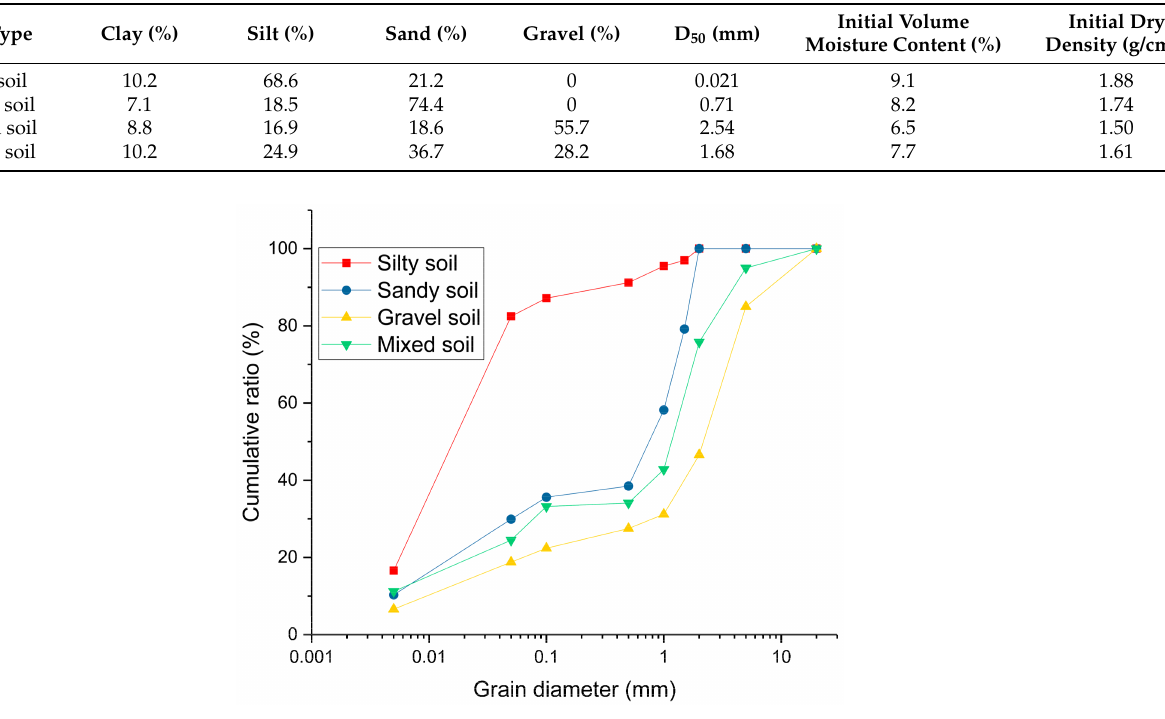
Figure 4. Grain size distribution